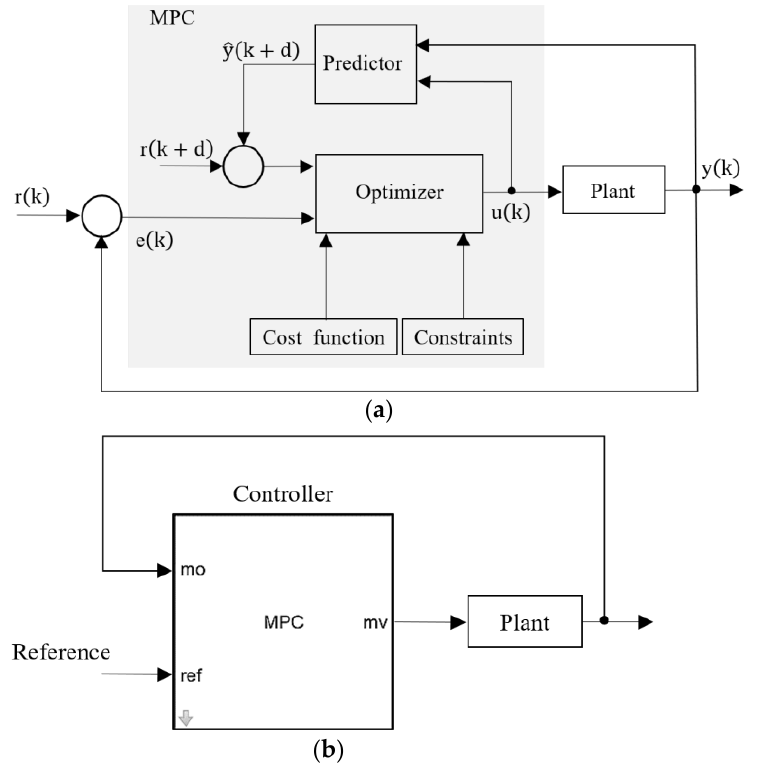
Figure 11. MPC architecture. ( a ) Diagram of MPC controller. ( b ) Block diagram of implementation